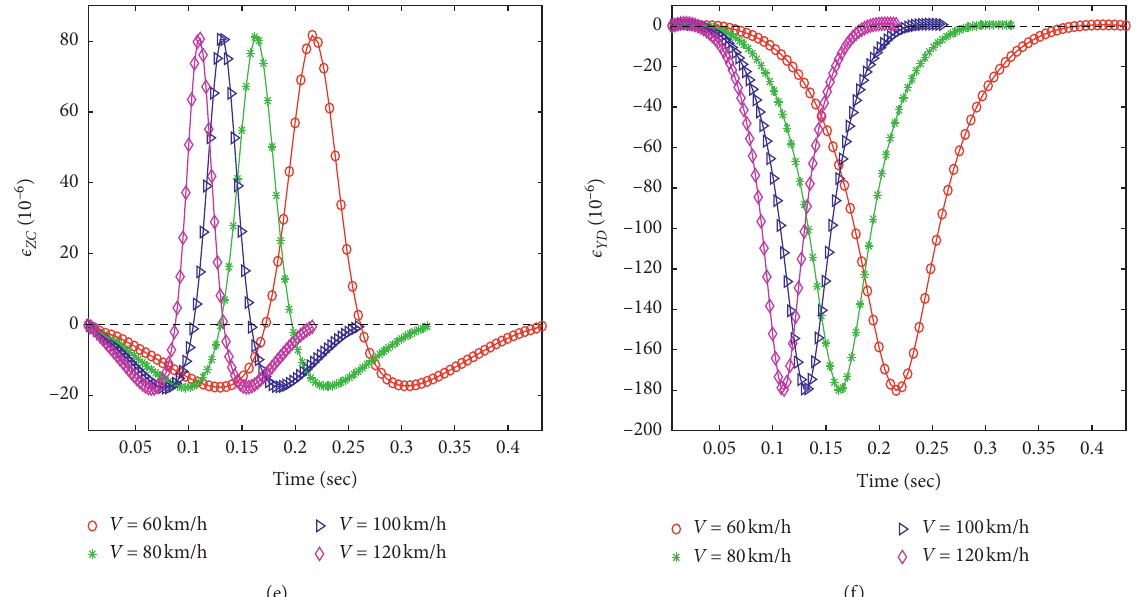
Figure 8: Response due to moving loads at the higher temperature. (a) U YA at different vehicle speed. (b) ε XB at different vehicle speed. (c) ε ZB at different vehicle speed. (d) ε XC at different vehicle speed. (e) ε ZC at different vehicle speed. (f) ε YD at different vehicle